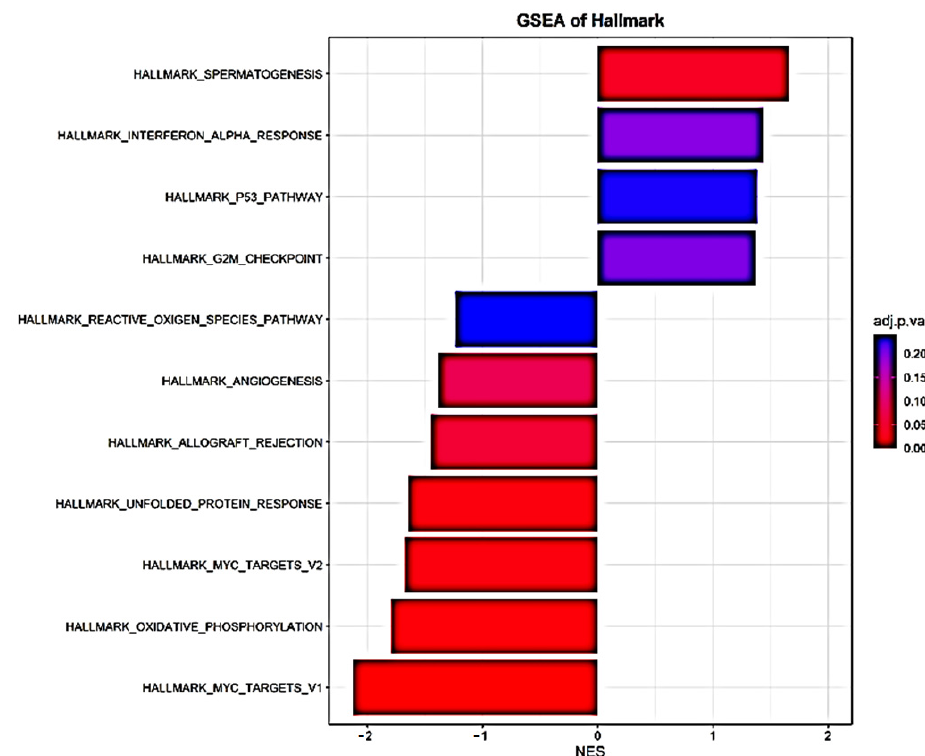
Figure 3. Histogram of Hallmark-gene-set enrichment analysis of transcriptional differences in whole blood associated with mortality in community-acquired pneumonia.